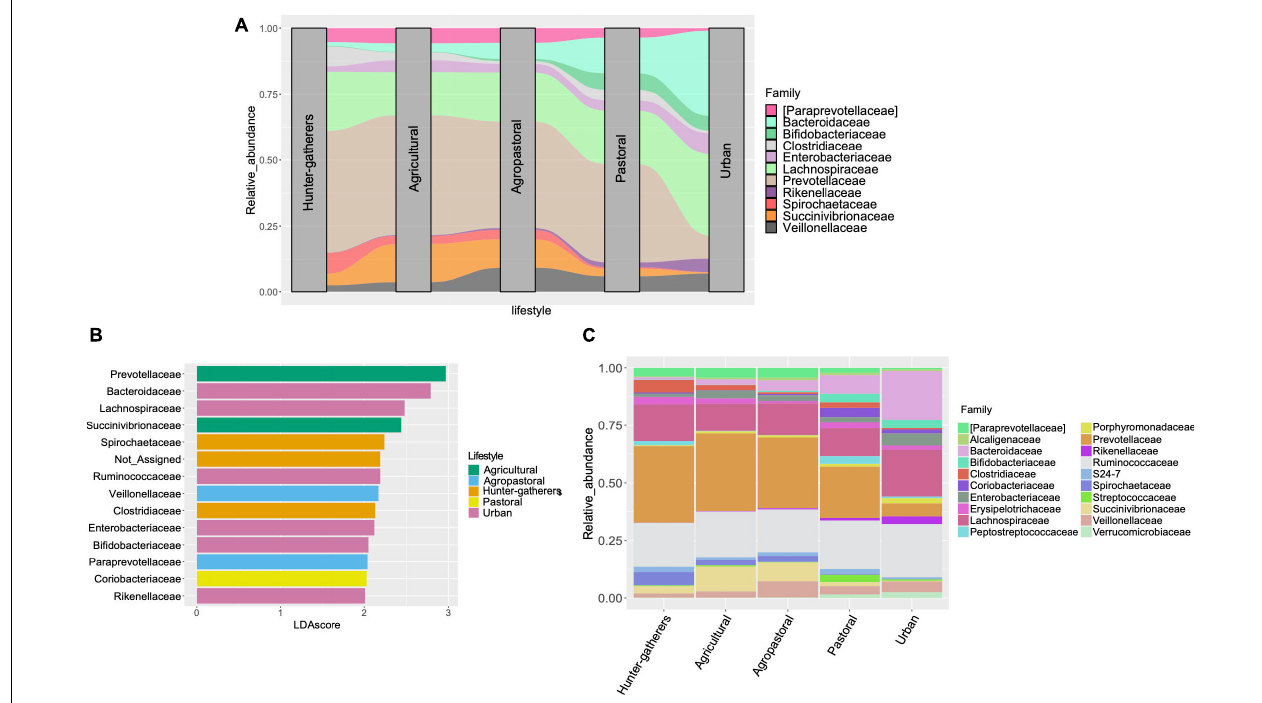
FIGURE 3 | Differentially abundant bacterial families between lifestyles. (A) Alluvial plot representing the differentially abundant families among lifestyles according to LEfSe and DEseq2 analyses. (B) Linear Discriminant Analysis with Effect Size (LEfSe) at the family level between lifestyles. Only features with LDA score higher than 2.0 and p < 0.05 were included. (C) Stacked barplot of relative abundance of the top 20 most abundant bacterial families in each